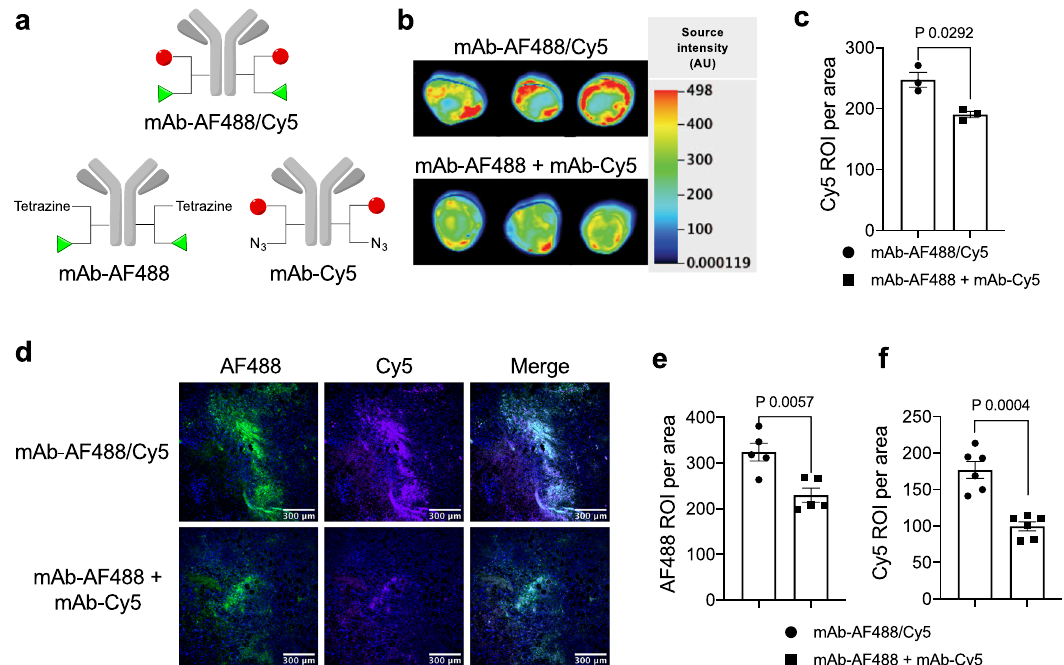
Fig. 7 Evaluation of payload delivery ef fi ciency by the dual conjugate format. a Structures of anti-HER2 AF488/Cy5 dual-dye conjugate (DOL of 2 + 2) and single-dye variants (DOL of 2). b , c Whole tumor fl uorescence imaging of JIMT-1/MDA-MB-231 (4 : 1) admixed tumors 24 h after intravenous administration of mAb – AF488/Cy5 (3 mg kg − 1 , black circle) or a 1 : 1 cocktail of mAb – AF488 and mAb – Cy5 (3 mg kg − 1 each, black square) into tumor- bearing female NU/J mice ( n = 3 per group). Fluorescence images of the whole tumors ( b ) and semi-quanti fi cation ( c ) detected using a 700 nm channel. d – f Fluorescence microscopic imaging of the tumor tissues. Fluorescence images of the frozen sections (AF488 and Cy5 channel, scale bar: 300 µ m ( d ) and semi-quanti fi cation (AF488 channel ( e ) and Cy5 channel ( f )). For tissue section analysis, six areas were randomly selected from the tissue sections and normalized signal intensity (intensity in each region of interest divided by area) was calculated using ImageJ software. Data are presented as mean values ± SEM ( n = 6). For statistical analysis, a two-tailed Welch ’ s t -test was used. This experiment was repeated twice independently with similar results. Source data are available as a Source Data fi le. AF488, Alexa Fluor ® 488; DOL, degree of